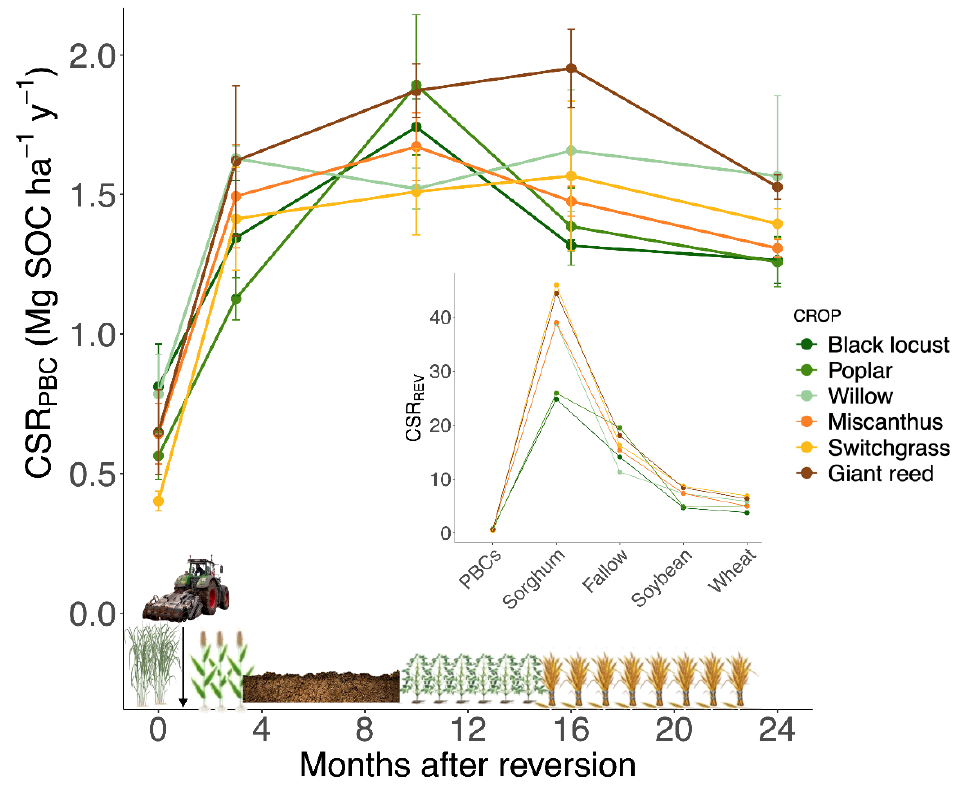
Figure 3. Carbon sequestration rates (CSR PBC , Mg SOC ha −1 y −1 ) and its variation (CSR REV , Mg SOC ha −1 y −1 ) before and after the reversion of perennial biomass crops.